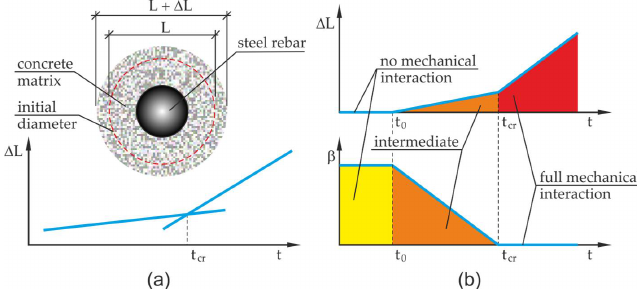
Figure 3. Methodology for determining critical time t cr and function β : ( a ) method of determination of critical time as the intersection point of regression lines, ( b ) course of changes of function β together with the description of the impact of corrosion products on concrete.